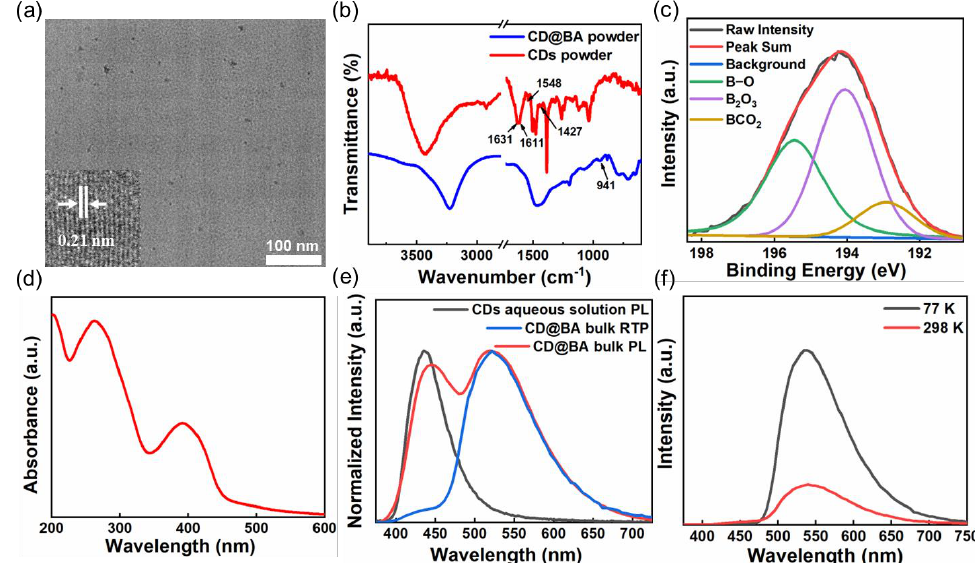
Figure 2. ( a ) TEM image of the CD@BA and inset, corresponding HRTEM image; ( b ) FTIR spectra of CDs and CD@BA powder; ( c ) High-resolution B 1s XPS spectrum of CD@BA powder; ( d ) UV-visible absorption spectrum of CDs aqueous solution; ( e ) PL emission spectrum of the CDs aqueous solution, PL and RTP emission spectra of the CD@BA bulk; ( f ) RTP emission spectra of CD@BA bulk at 298 and 77 K, under 365 nm excitation.